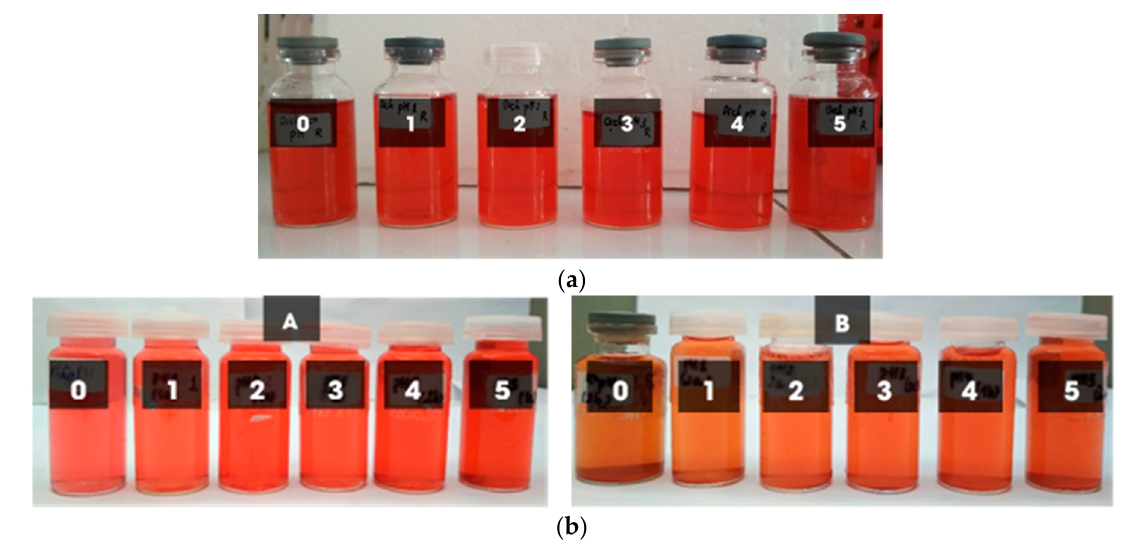
Figure 8. The transformation of color of the five aqueous solutions of the fruit extract in different conditions over time: ( a ) at initial stage, ( b ) after 4 weeks at room temperature (A), and after 4 weeks at 45 °C (B).